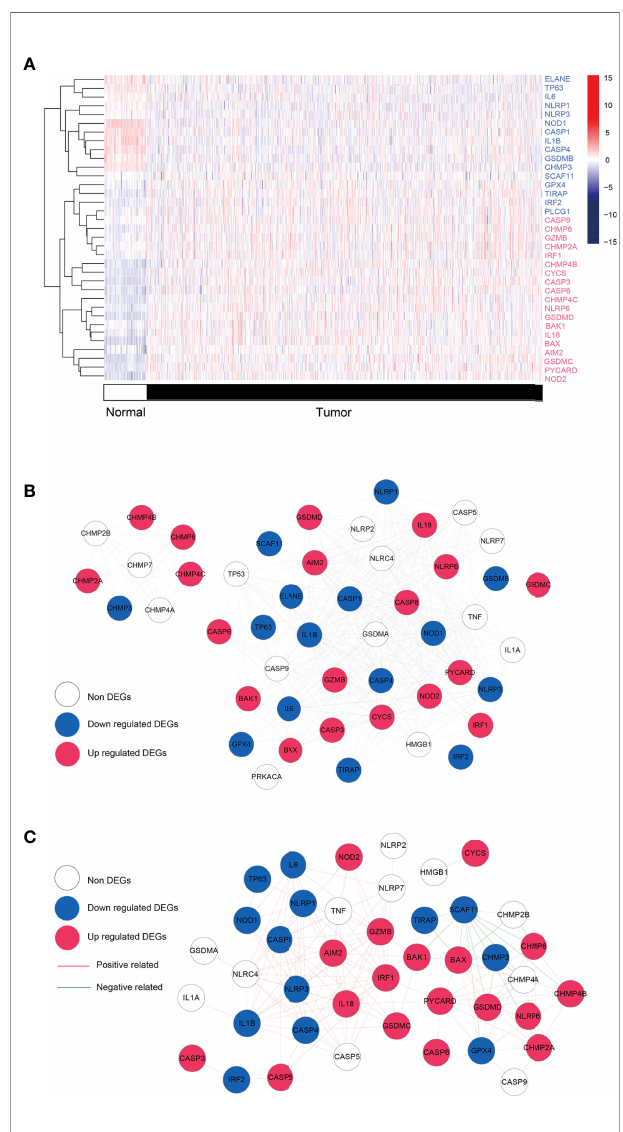
FIGURE 2 | Differential analysis and network. (A) Heatmap showing the expression levels of pyroptosis-related genes with signi fi cant expression levels in breast cancer tumors and control samples. Red: up regulated; blue: down regulated. (B) Protei-protein interaction. Blue, red, and white nodes represent genes that are signi fi cantly down-regulated, up-regulated, and insigni fi cantly differentially expressed in tumor tissue, respectively. (C) co-expression network based on pyroptosis-related genes. Blue, red, and white nodes represent signi fi cantly down-regulated, up-regulated, and insigni fi cantly differentially expressed genes in tumor tissues, respectively. Red and green junctions represent signi fi cantly positive and negative